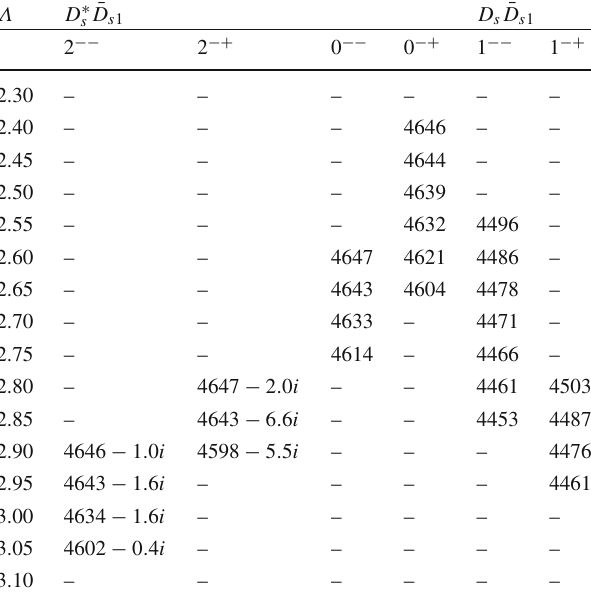
Table 3 More bound states from the interaction D ∗ s ¯ D s 1 − D s ¯ D s 1 at different cutoffs Λ in a range from 0.5 to 5 GeV. Here, “–” means that no bound state is found or the bound state has a binding energy larger than 50 MeV. The cutoff Λ and position of the pole z are in units of GeV and MeV,